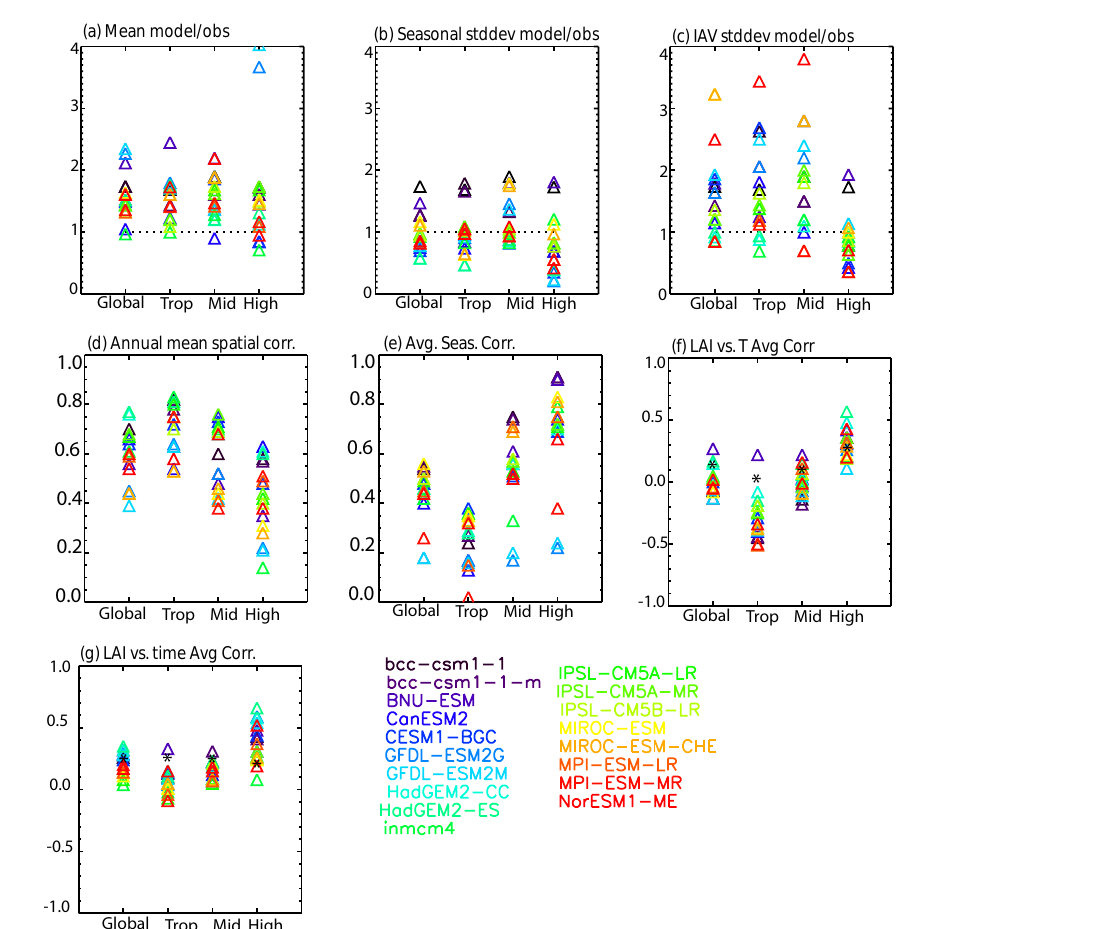
Figure 8. Comparison of model metrics for the LAI comparisons from Table 2 across the models, for each region (global, tropical, mid- latitude and high latitude) for (a) mean of the model divided by mean of the observations, (b) seasonal SD mean of the model divided by mean of the observations, (c) IAV SD mean of the model divided by mean of the observations, (d) spatial correlation of model to observed LAI, (e) average temporal correlation for seasonal variability, (f) average IAV LAI correlation with temperature ( ∗ indicates observed value), (g) average IAV LAI correlation with time ( ∗ indicates observed